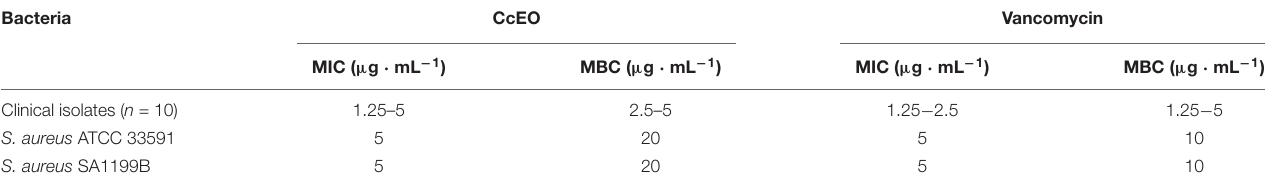
TABLE 2 | MIC and MBC values of the Cuminum cyminum L. essential oil (CcEO) against S. aureus bacteria. Bacteria CcEO